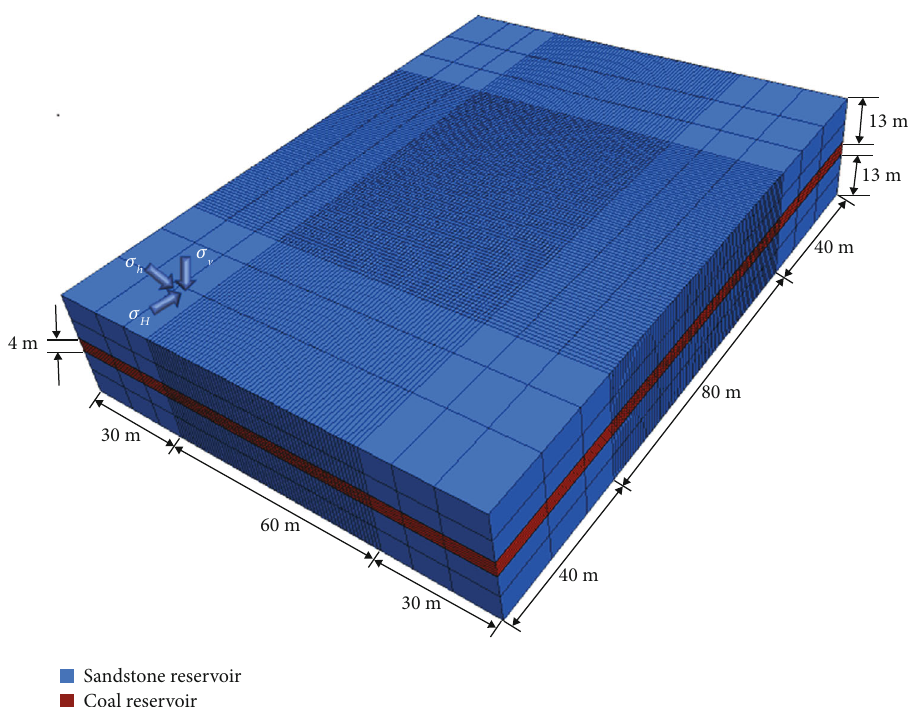
Figure 9: Spatial distribution of hydraulic fracturing boreholes in combination with a regular distribution of hydraulic slots.